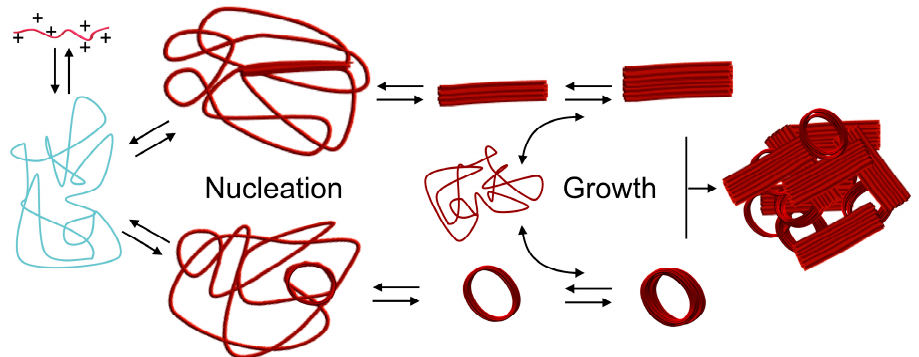
Figure 1. DNA condensation process induced by polycations. ( a ) DNA is hydrated to form coiled conformation. When complexed with polycations for polyion pairing ( b ), the polyplex undergoes volume transition by intra-polyplex association ( c ), followed by growth to large aggregates by inter-polyplexassociation( d ). ArepresentativeTEMimageofpDNA / P(Lys) 40 polyplexes. ( e )(i) globular, ( e )(ii) rod-shape, and ( e )(iii) toroid.